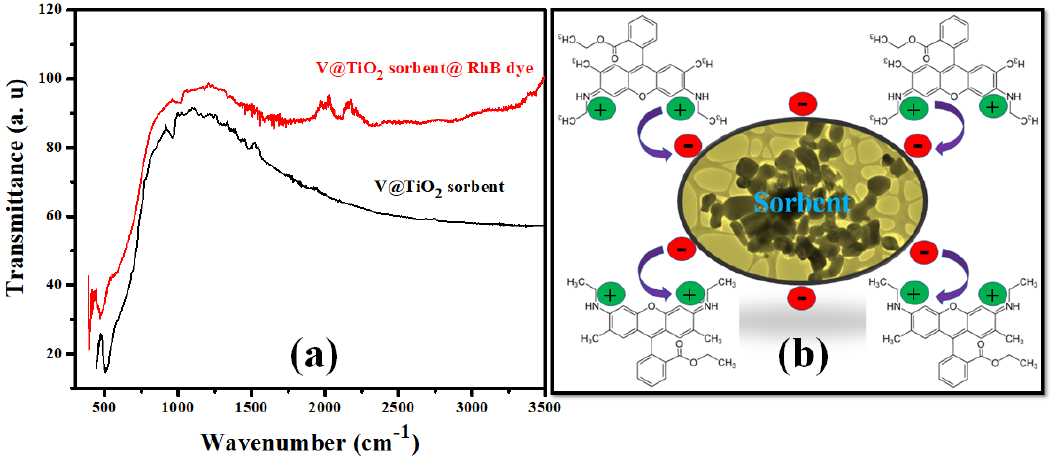
Figure 10. ( a ) FTIR spectra of the V@TiO 2 nanocomposite and Rh-B @ V@TiO 2 nanocomposite; ( b ) the suggested removal mechanism of Rh-B dye by the V@TiO 2 nanocomposite.